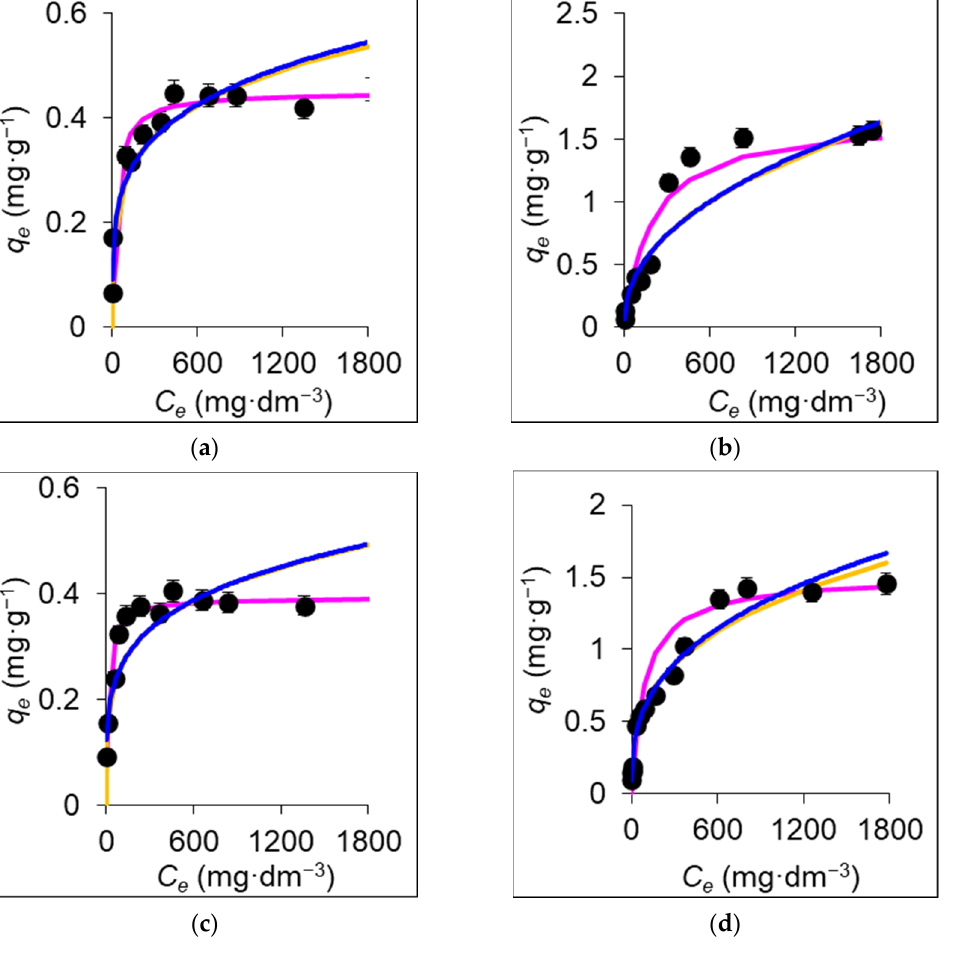
Figure 2. Experimental data of Cu sorption on Z-M50 from ( a ) CuSO 4 ( b ) Cu(NO 3 ) 2 , and Zn sorption on Z-M50 from ( c ) ZnSO 4 ( d ) Zn(NO 3 ) 2 . Note: black dots—experimental data ± standard deviation; blue line—Freundlich isotherm, pink line—Langmuir isotherm, orange line—Redlich–Peterson isotherm. Table 3. Adsorption isotherm parameters of Cu and Zn on zeolites.